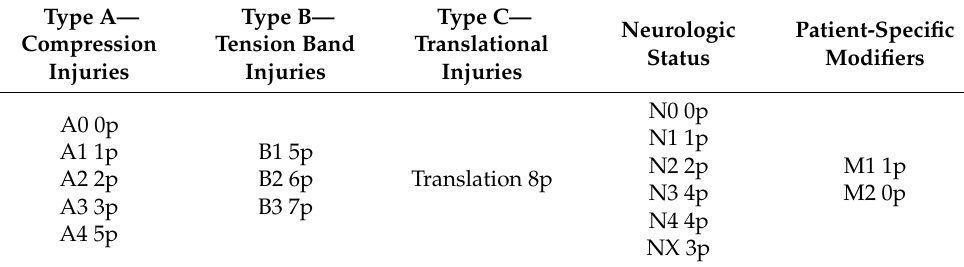
Table 2. Original TL AOSIS classification as published by Vaccaro in 2016